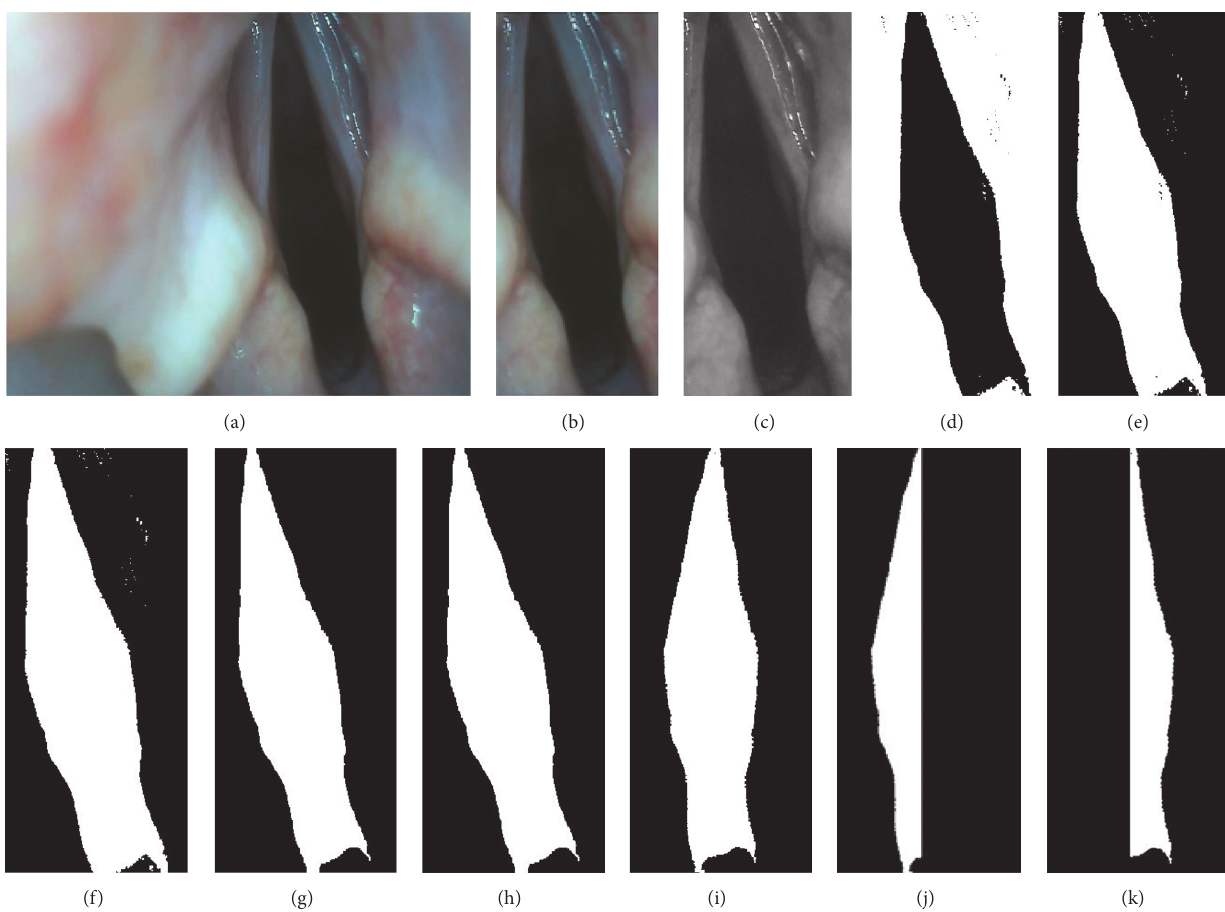
Figure 3: Procedure of measuring glottis movement. (a) Original image frame. (b) Extraction of glottis. (c) Grayscale image. (d) Converting of black-white image with a grayscale threshold. (e) Inverted black-white image. (f) Removing of extra black punctae within the glottis. (g) Removing of the slim link around the glottis by using image erode. (h) Removing of small island by using an area threshold. (i) Rotation of the image. ((j) and (k)) Division of left and right part of